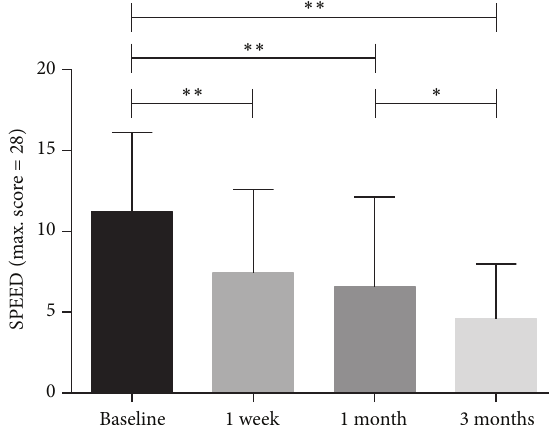
Figure 1: The mean value of test-eye Standard Patient Evaluation of Eye Dryness (SPEED) score measured at baseline, at one week, at one month, and at three months ( ∗ 𝑝 < 0.05 , ∗∗ 𝑝 < 0.001